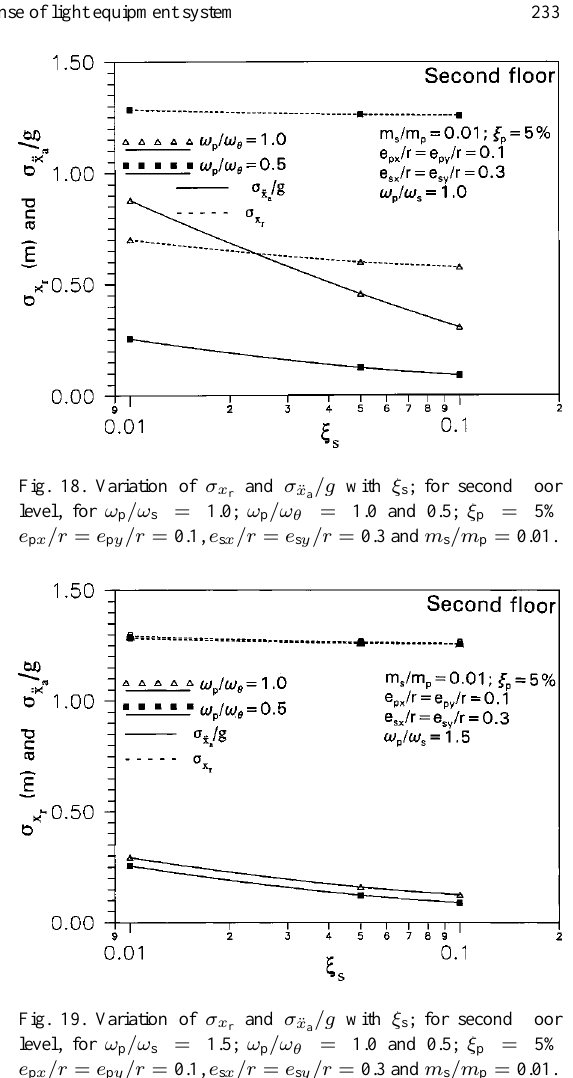
=g with e s x =r and e s y =r ; for sec- Fig. 17. Variation of (cid:27) x and (cid:27) (cid:127) x r a ond floor level, for m s =m p = 0.01; ! p =! s = 1.5; ! p =! (cid:18) = 1.0 and 0.5; e p x =r = e p y =r = 0.1; (cid:24) p = 5% and (cid:24) s = 2%.